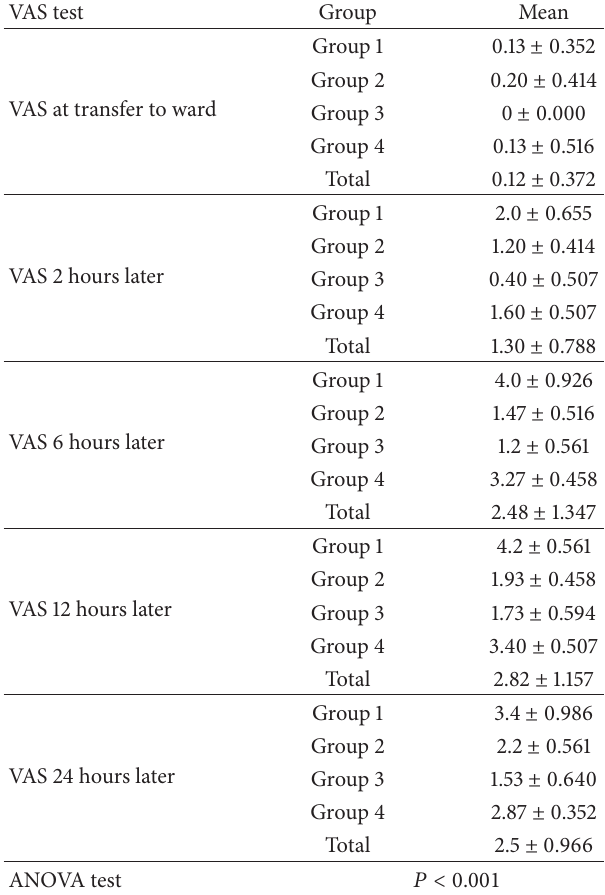
Table 3: VAS frequency among